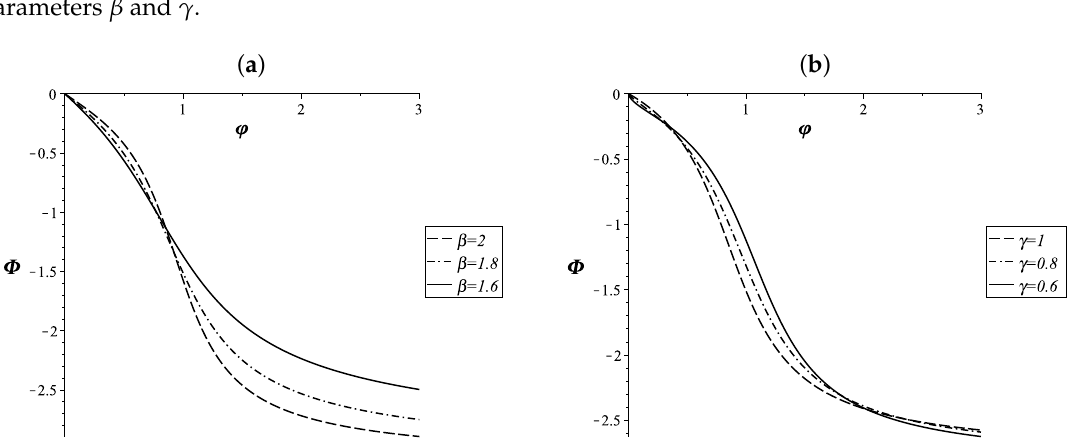
Figure 5. PFC curves plotted for different values of β and a fixed value of γ = 1 ( a ) and for different values of gamma and a fixed value of β = 1.8 ( b